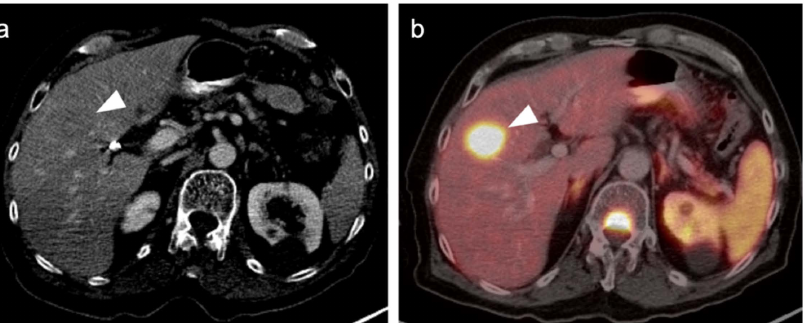
Figure 38. Comparison between contrast-enhanced CT and [ 68 Ga]Ga-DOTA-TATE (NETSPOT ® ) PET-CT in the detection of a hepatic carcinoid metastasis. ( a ) Axial contrast-enhanced CT image of the liver shows poor definition of a metastatic well-differentiated neuroendocrine tumor (white arrowhead). ( b ) Axial [ 68 Ga]Ga-DOTA-TATE PET-CT shows an intensely PET-positive metastasis (white arrowhead), suggesting well-differentiated histology. There is also a metastasis to the adjacent vertebral body. There are several left renal cysts.